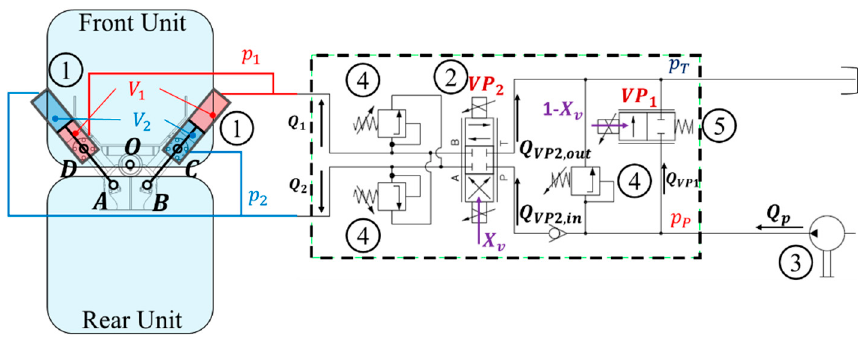
Figure 6. Hydraulic steering circuit 1—Double-acting cylinders; 2—Double-solenoid flow rate proportional valve; 3—Pump; 4—Pressure relief valves; 5—Single-solenoid flow rate proportional valve. Adapted with permission from ref. [19]. Copyright 2020 Springer Nature